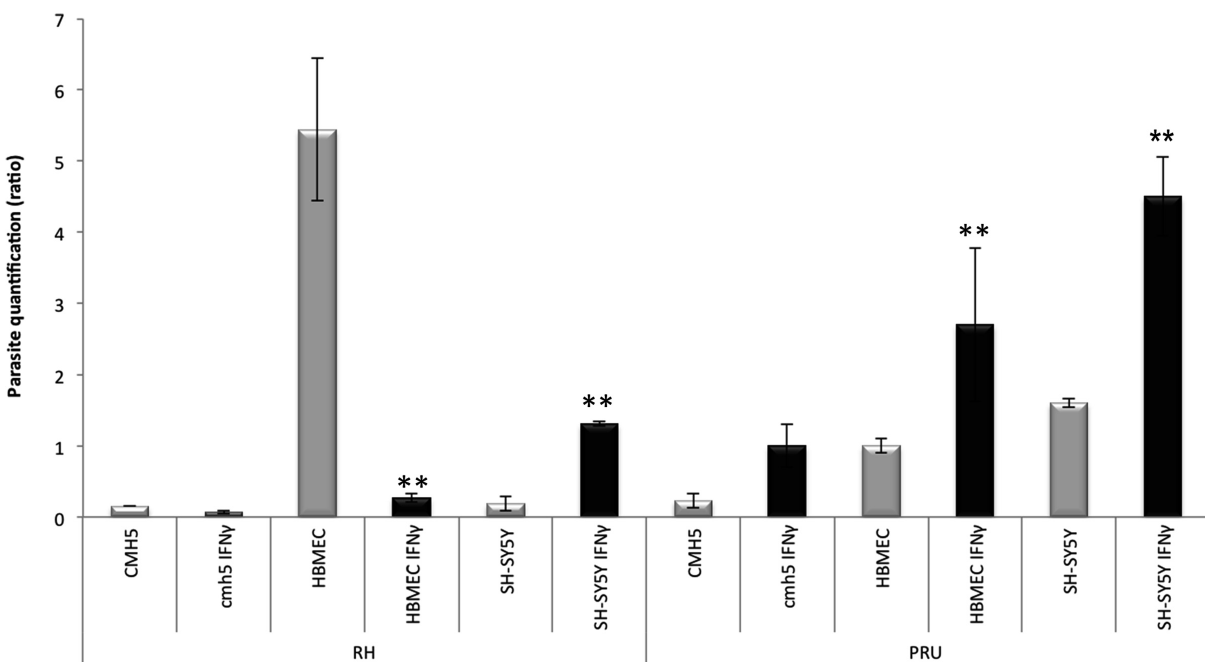
Figure 1. Effect of IFN- c on parasite multiplication. Microglial cells, endothelial cells and neurons were stimulated by IFN- c before being infected with the RH or PRU strain of T. gondii for 24 h. Parasite burden was quantified by semi-quantitative RT-PCR in stimulated and infected cells (black) and in non-stimulated and infected cells (grey). Parasite quantification was evaluated as follows: final number of